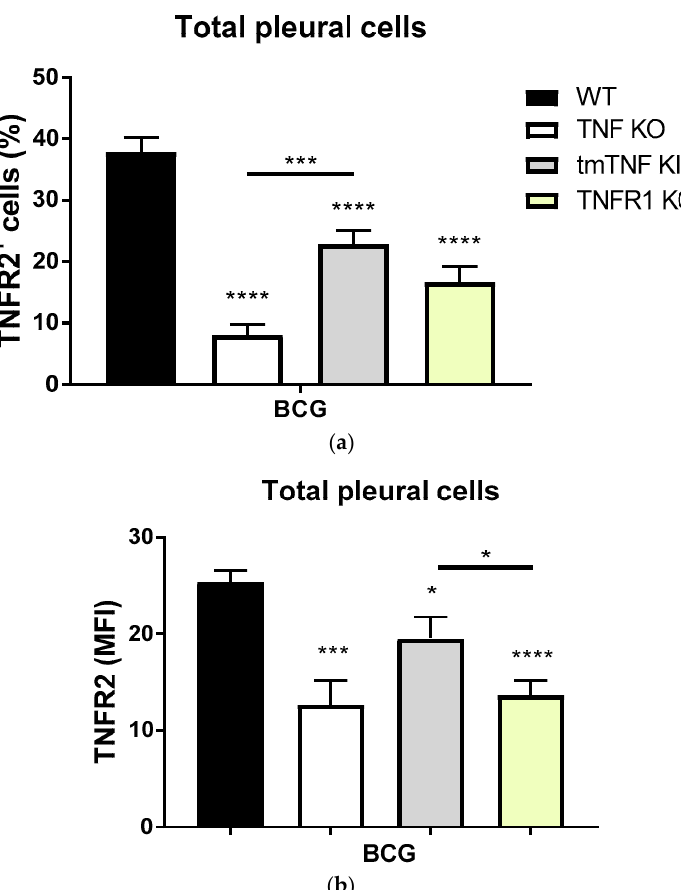
Figure 3. The expression of TNFR2 in the total pleural cells from BCG-induced pleurisy in mice. ( a ) Frequency of pleural cells expressing membrane TNFR2. Pleural cells from BCG-infected mice were analyzed at day 14 post-infection; ( b ) Mean fluorescence intensity of TNFR2 of pleural cells from BCG-infected mice at day 14 post-infection. Data are represented as bar graphs of means +/ − SEM ( n = 9 to 12 mice/per group). Comparisons are done between infected WT versus infected mutant mice or as indicated in the figure, * p < 0.05, *** p < 0.001, **** p < 0.0001.